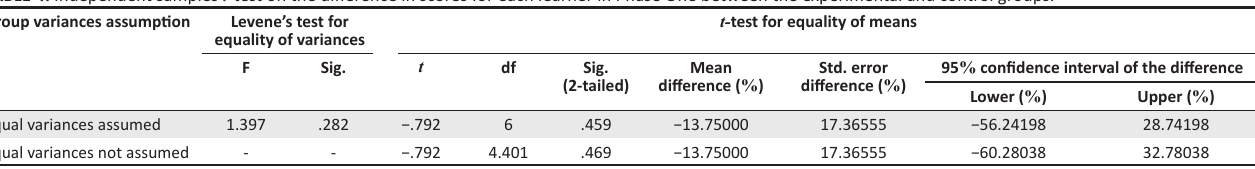
TABLE 4: Independent samples t -test on the difference in scores for each learner in Phase One between the experimental and control groups. Group variances assumption